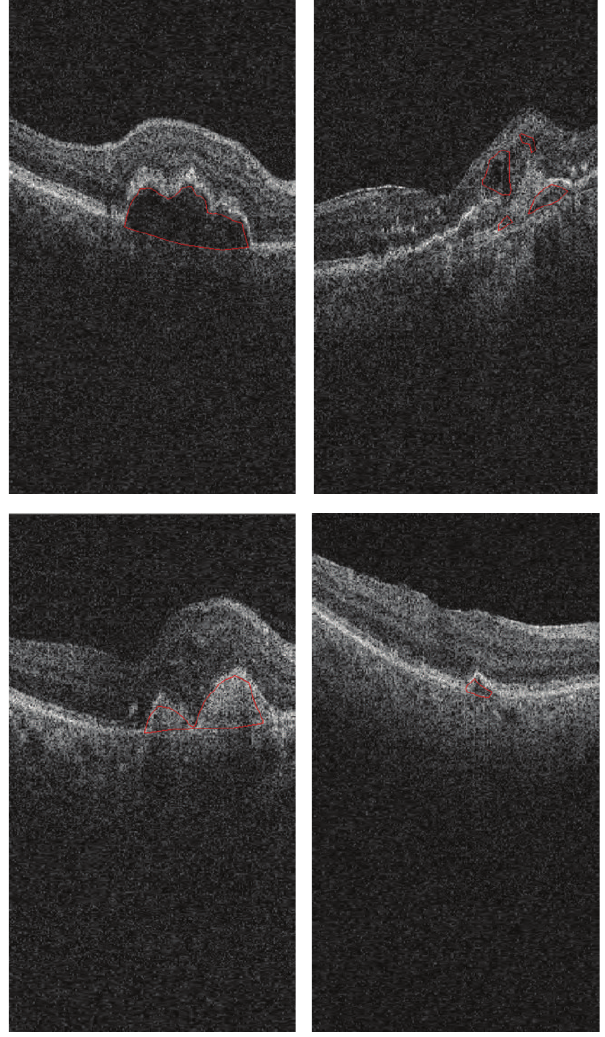
Figure 6: Macular OCTs and detected SEADs by an